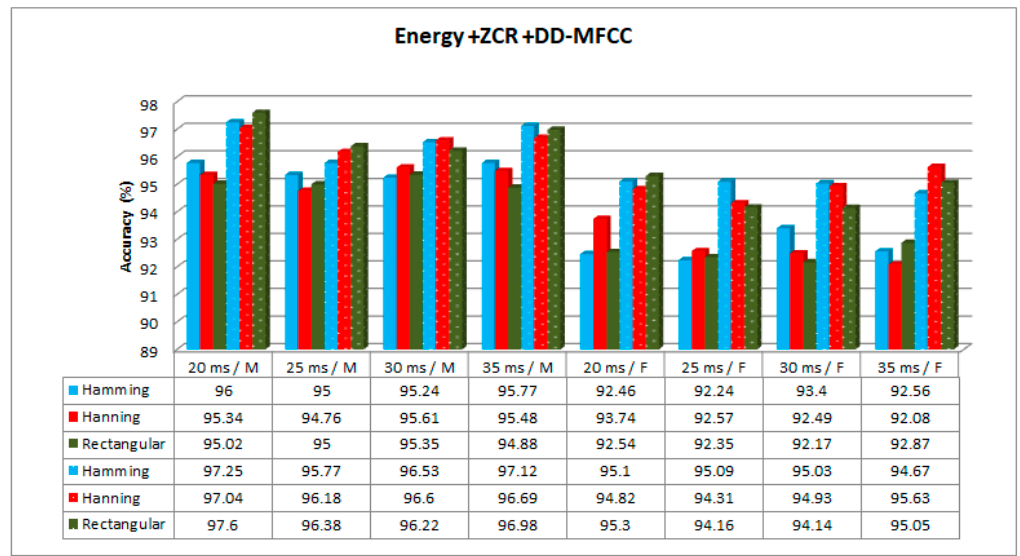
Figure 10. EZDMFCC accuracy results without GRU-based training (no dotted bars) and with GRU-based training (dotted bars) using a CNN classifier for male (M) and female (F) speakers.